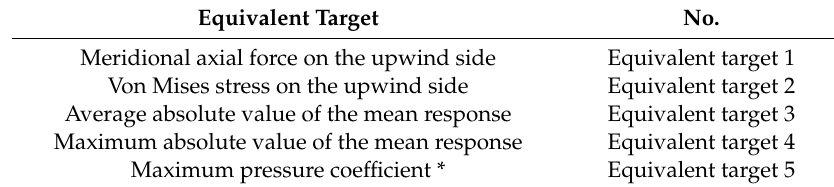
Table 5. Five equivalent targets for value determination of wind vibration coe ffi